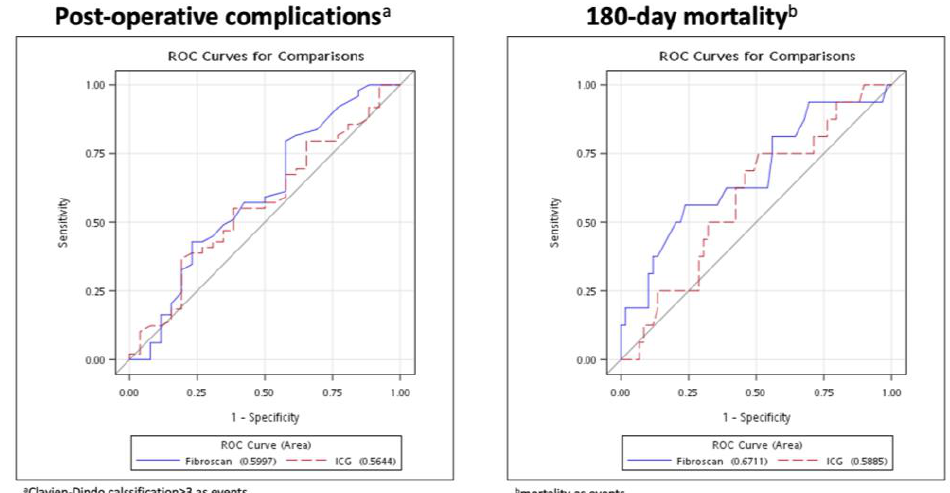
Figure 2. ROC curves of postoperative complications and 180-day mortality with comparison be- tween TE and ICG test. Abbreviations: TE, transient elastography; ICG, indocyanine green.